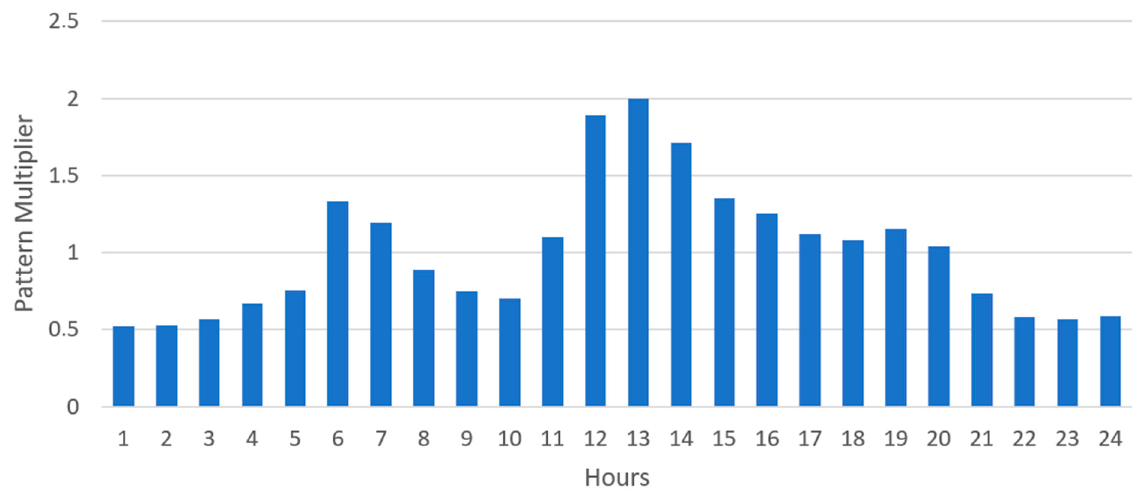
Figure 3. Distribution Pattern of 24 h for Messina WDN, implemented in EPANET.